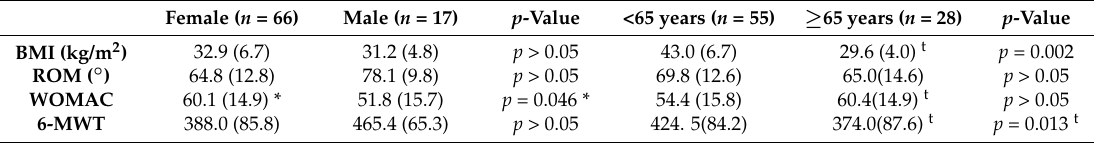
Table 2. Body mass index (BMI) and physical functionality outcomes ( n = 83).